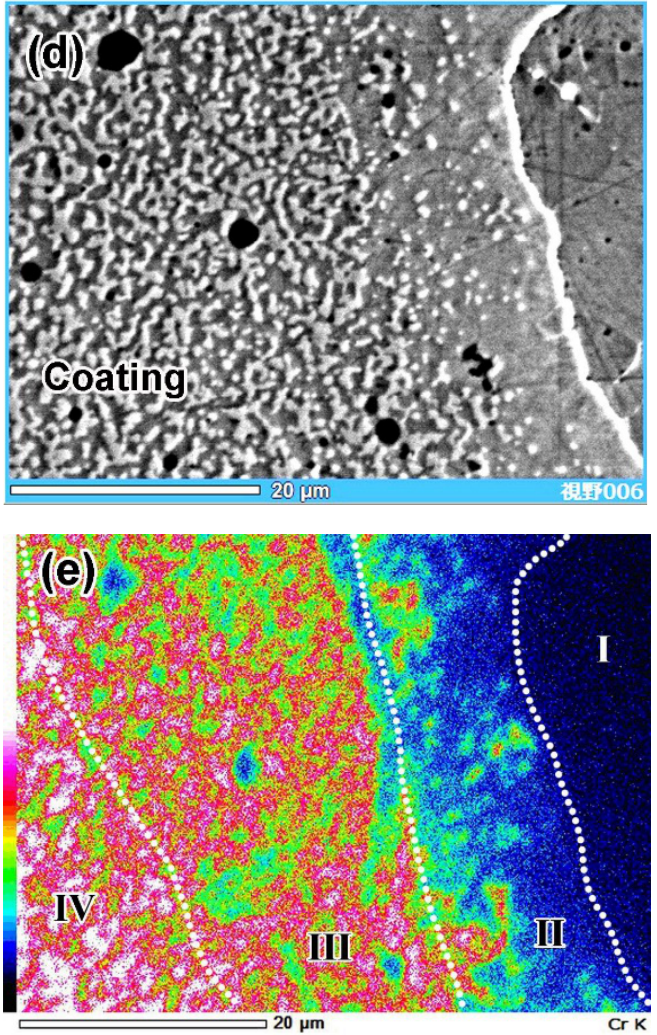
Figure 4. EDS analysis results: ( a ) Elemental mapping of C, Fe, Cr, and Mn. ( b , c ) EDS spectra of the local chemical analysis at points 001 and 003, respectively. ( d ) SEI image and ( e ) Cr mapping of the transition layer.